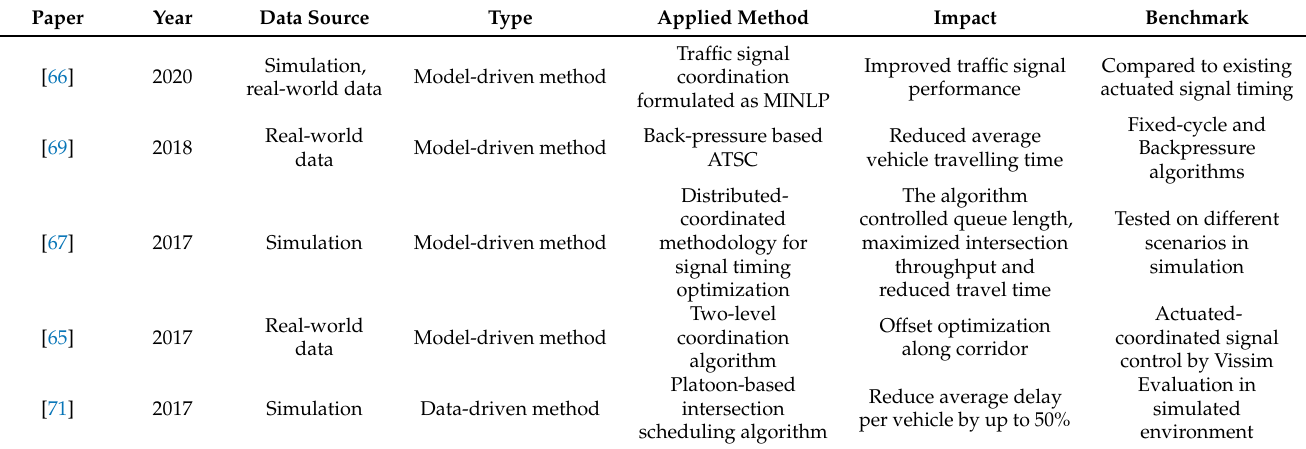
Table 3. Tabular overview of referenced papers regarding CV and CAV based